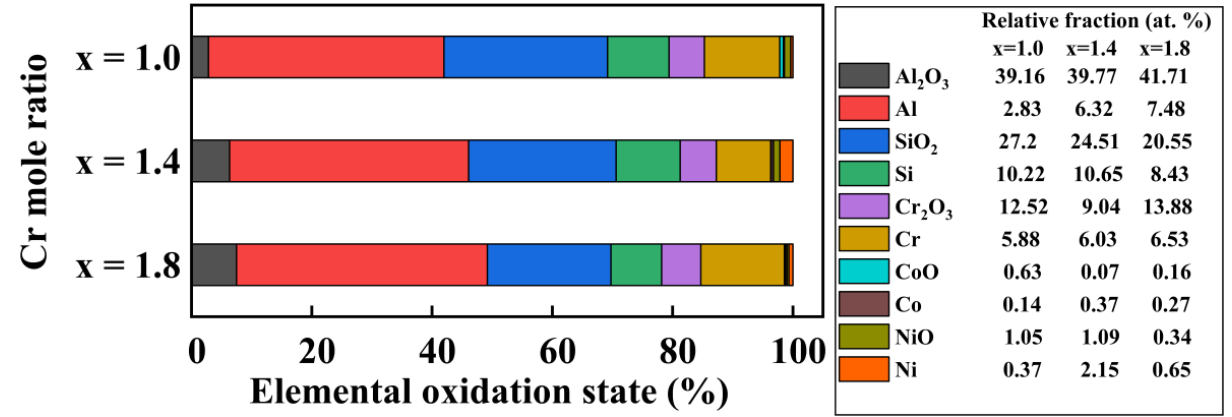
Figure 10. XPS semi-quantitative analysis for chemical compositions (at.%) for AlSi 0.5 Cr x Co 0.2 Ni high entropy alloys (x = 1.0, 1.4, and 1.6).